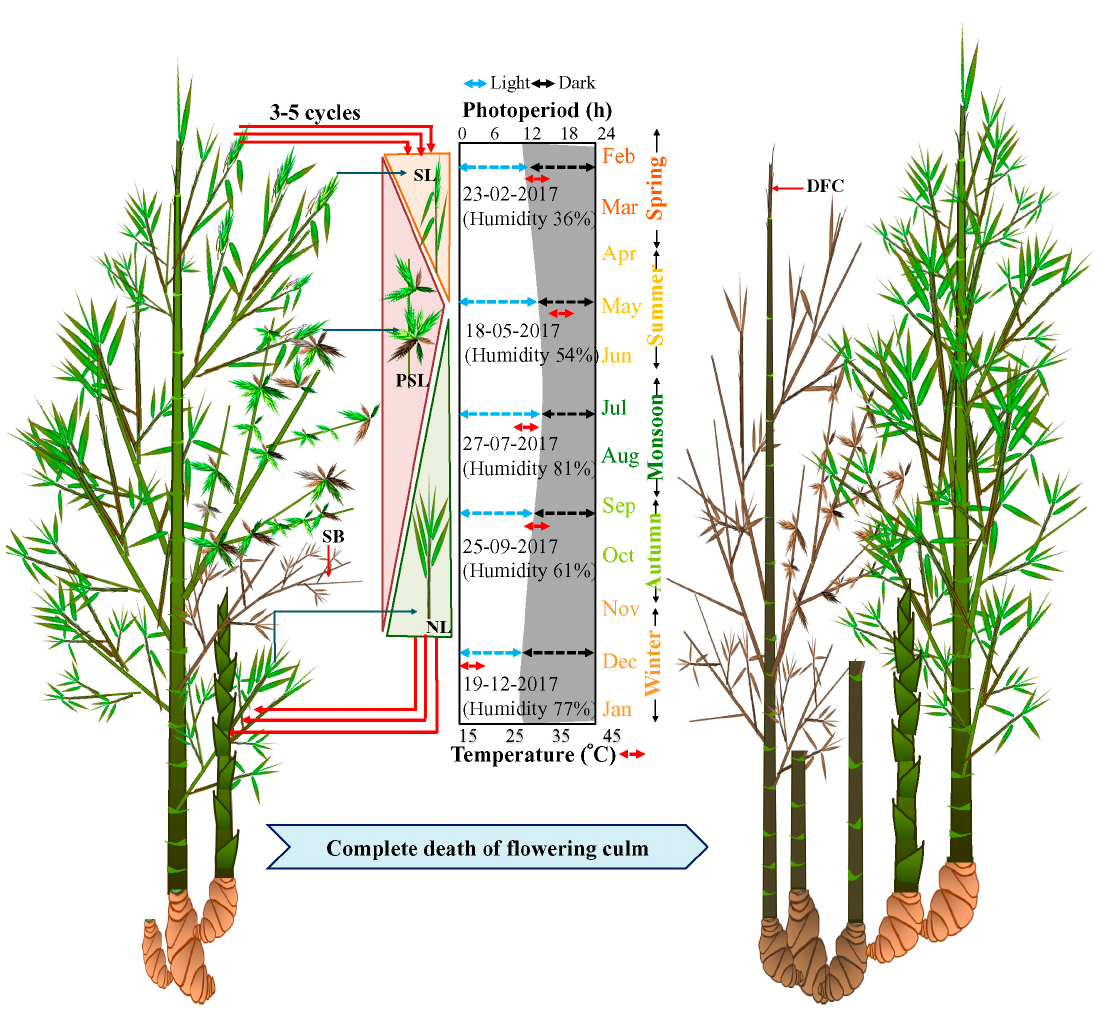
Figure 2. Induction of sporadic flowering and seasonal effect on emergence of solitary spikelet and pseudospikelet in B. tulda . Abbreviations used: SB—Senesced flowering branch, SL—Solitary spikelets, PSL—Pseudospikelets, NL—New leaf, DFC—Dead flowering